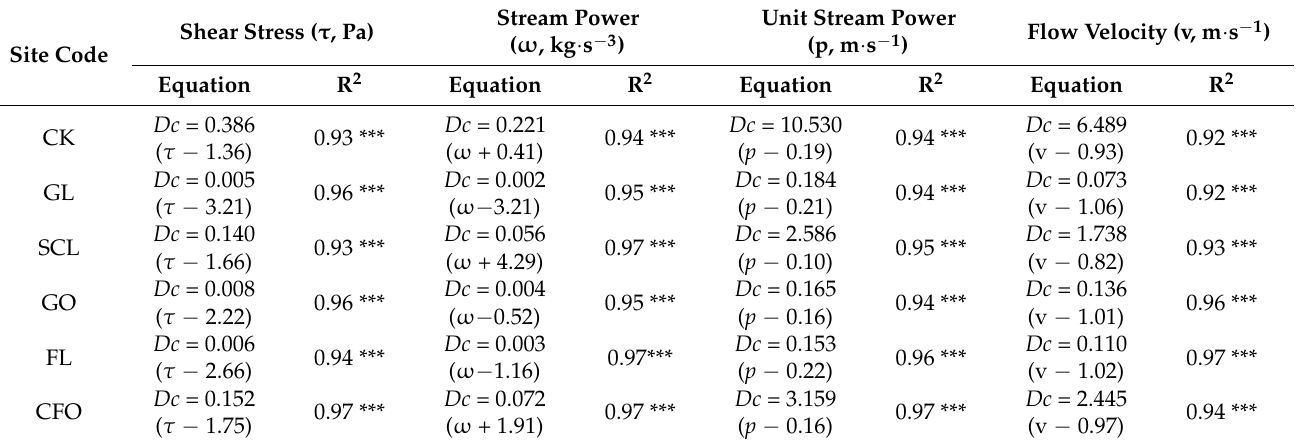
Table 3. Regression results of soil detachment capacity with shear stress, stream power, unit stream power, and flow velocity under different land use types.